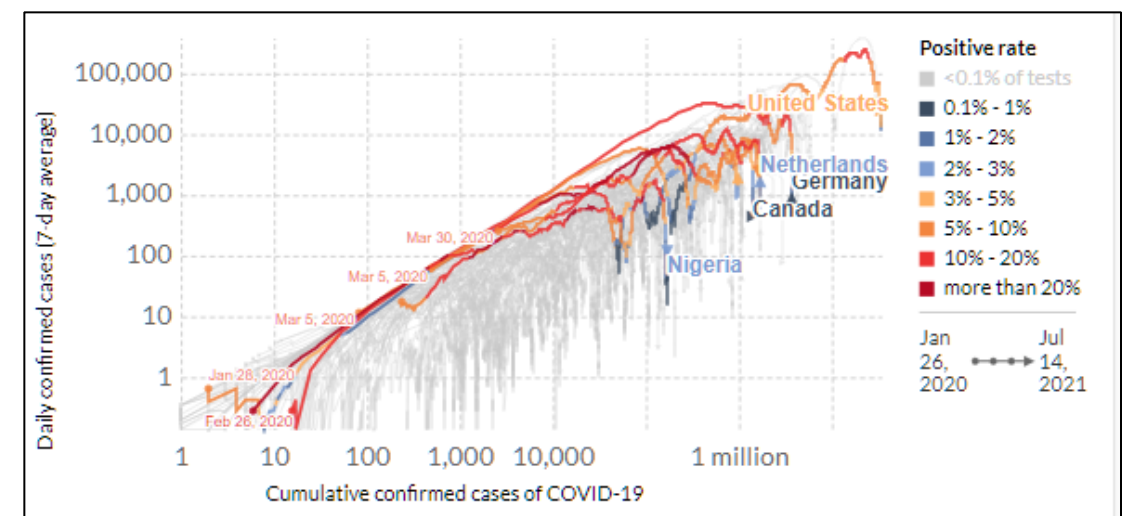
Figure 1. Cumulative confirmed global cases of COVID-19 (data source: www.Ourworldindata.org accessed 13 July 2021, Ritchie et al. [10]).